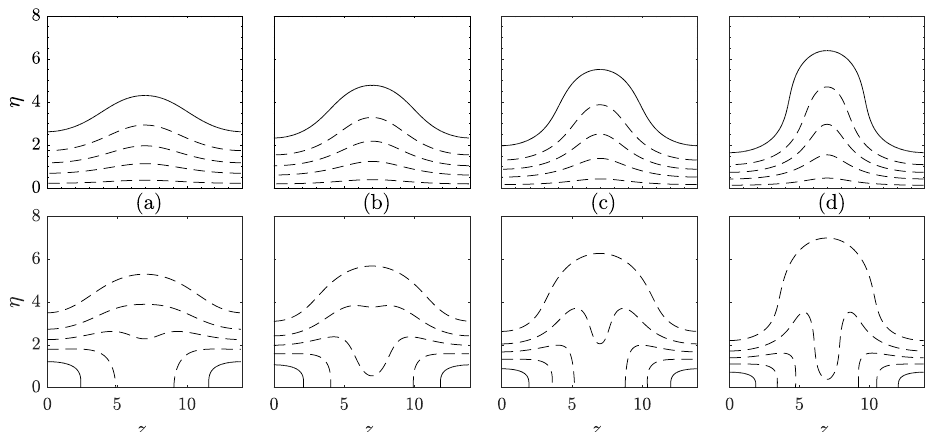
= 0.14 ( a ), 0.20 ( b ), 0.28 ( c ), and 0.36 ( d ), Figure 2. Streaks with a maximum amplitude of A s max attained at streamwise locations of (a) Re δ = 580, (b) Re δ = 570, (c) Re δ = 544, and (d) Re δ = 486. The top row corresponds to the streamwise velocity field u , while the bottom row stands for the shear rate u s . The dash line indicates contour levels 0.1,0.3,0.5,0.7, with level 0.9 marked with a solid line.